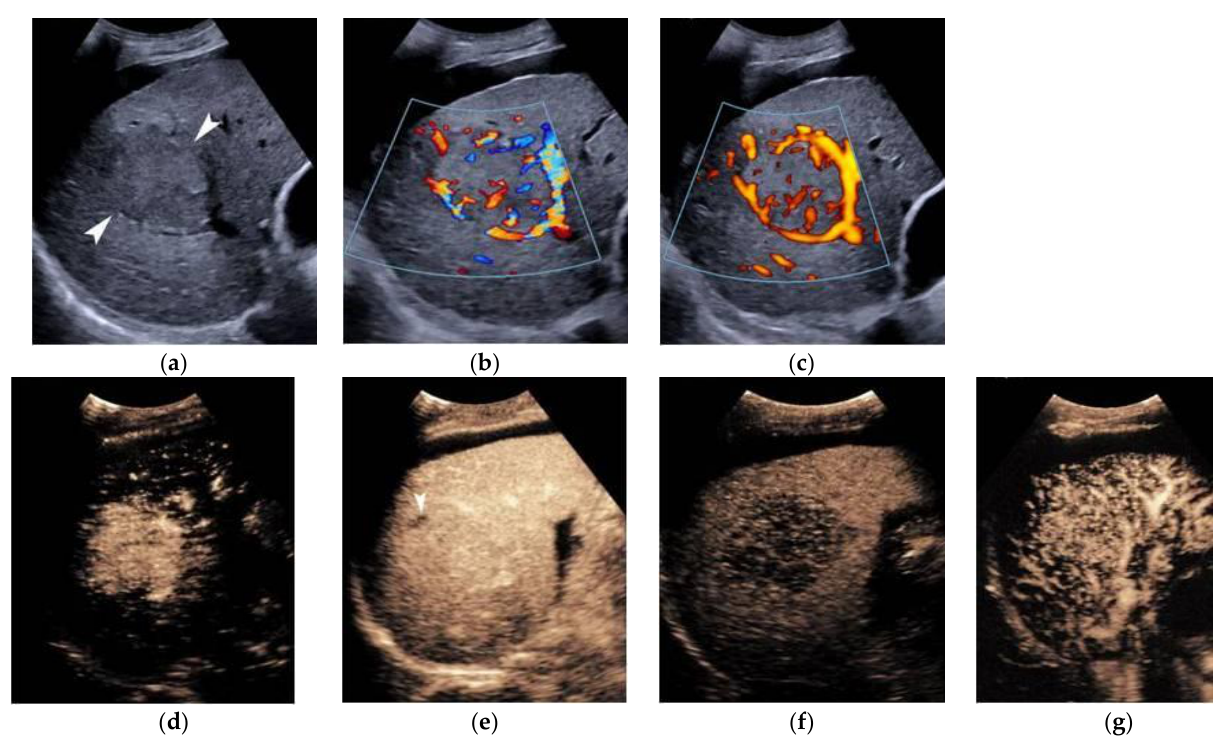
Figure 2. CEUS findings of a large HCC. B-mode ( a ) showing an ill-defined mildly hypo-echoic mass (outlined by arrowheads) inside the right lobe of a cirrhotic liver complicated with ascites. Colour ( b ) and power ( c ) Doppler technique visualizing the irregular internal vascular pattern of the mass. Note the increased vascularity locally. Arterial ( d ), venous ( e ), and delayed ( f ) CEUS image showing arterial phase hyperenhancement prior to adjacent hepatic parenchyma, iso-enhancement on portal-venous phase, and wash-out on the delayed phase (approximately 3 min). Note the area of necrosis appearing as non-enhancing (arrowhead on ( e )). Temporal MIP image ( g ) showing the vascular architecture of the mass. Note the dense and irregular vascularity indicated inside the lesion.